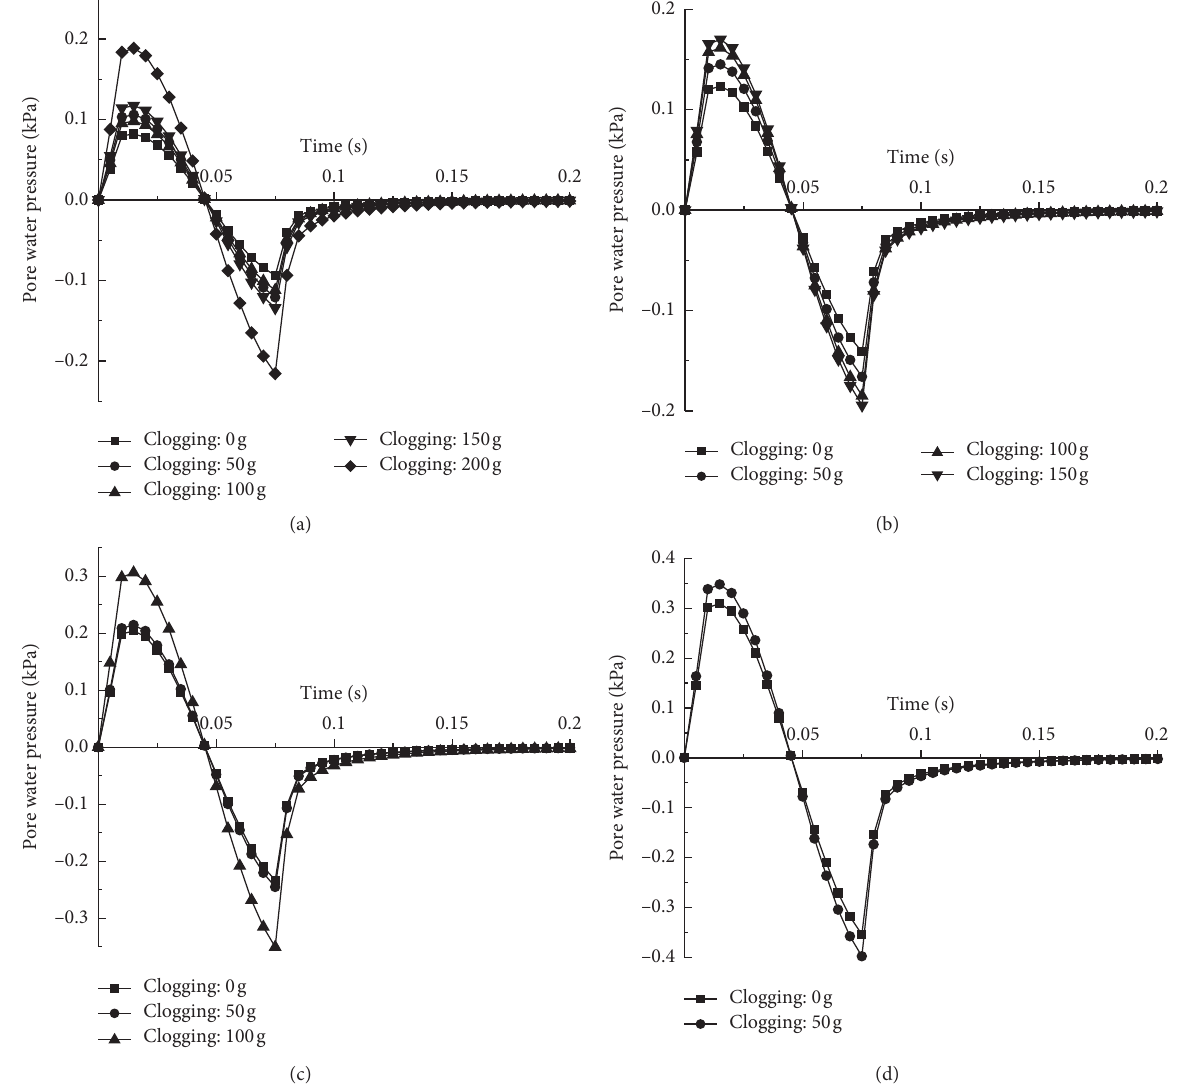
Figure 8: Pore water pressure at a depth of 3 cm ((a) void rate is 25%; (b) void rate is 23%; (c) void rate is 20%; (d) void rate is